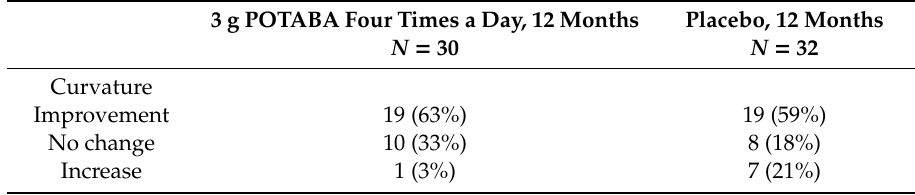
Table 8. POTABA use in acute Peyronie’s disease: Randomized, Double-Blind, Placebo-Controlled. 3 g POTABA Four Times a Day, 12 Months